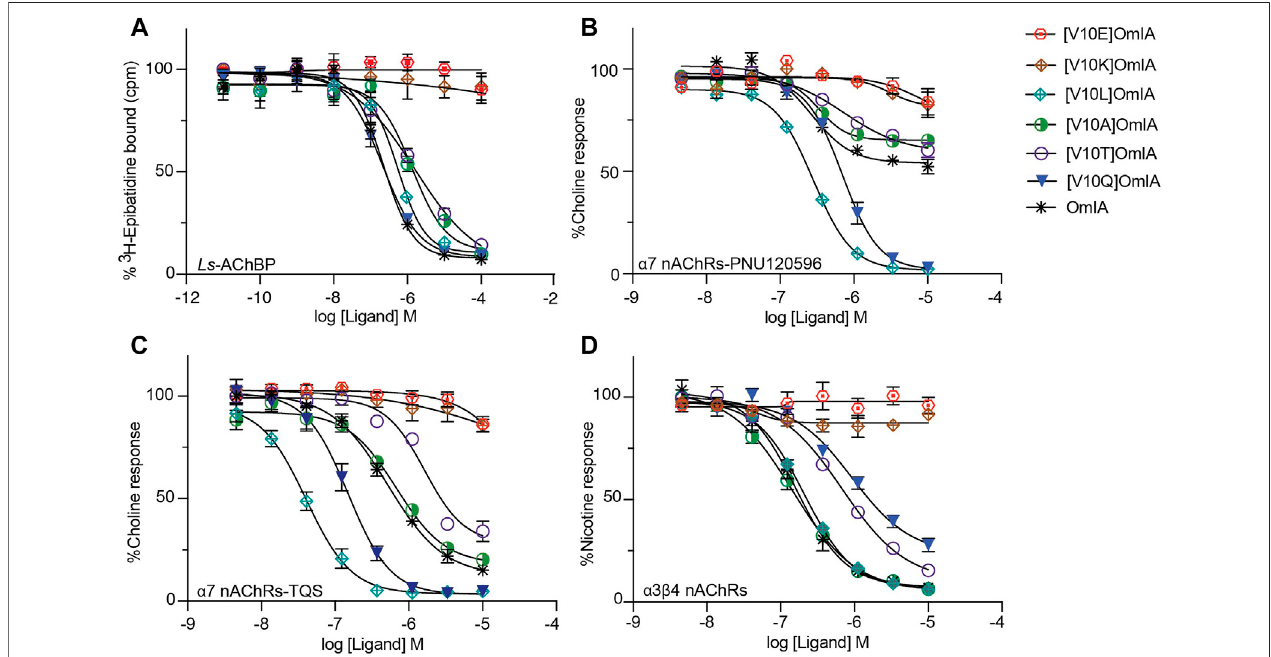
FIGURE 5 | Activity of OmIA and its analogues at position 10 at Ls-AChBP, α 7 nAChRs with the addition of nAChR type II PAM PNU-120596, TQS and α 3 β 4 nAChRs. (A) Displacement of [ 3 H]-epibatidine from Ls -AChBP. The inhibition of choline activation of α 7 nAChRs with PNU-120596 (B) , TQS as PAMs (C) and inhibition of nicotine activation of α 3 β 4 nAChRs (D) by OmIA and its analogues at position 10, measured in a FLIPR Ca 2+ in fl ux assay on SH-SY5Y cells. Data represent mean ± SEM of triplicate data from three independent